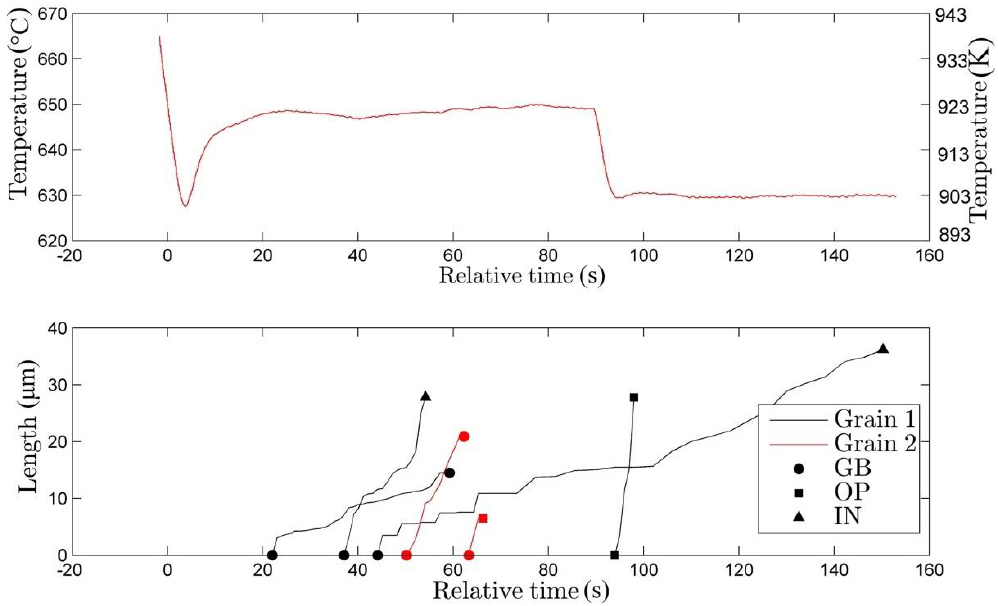
Figure 11. Temperature versus time and temporal plate growth sequence of bainitic ferrite plates in Fe-0.2C-1.5Mn-2.0Cr during isothermal holding treatment at 923 K (650 °C).